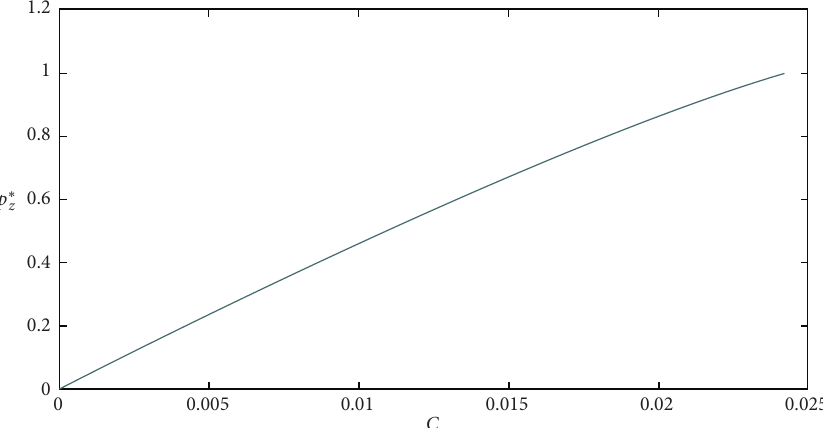
Figure 2: Simulation diagram of the impact of rent-seeking cost on optimal supervision probability p ∗